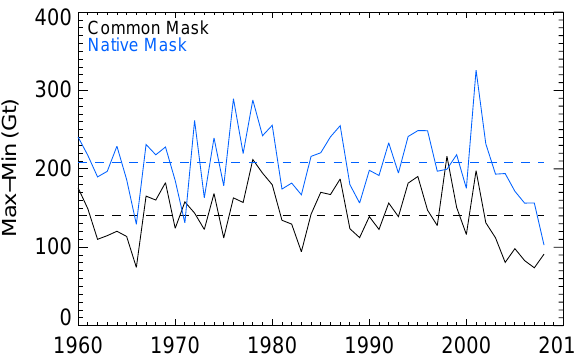
Fig. 3. Spread between highest and lowest modelled SMB annual series on the common (141Gt) and native (208Gt) masks. Dashed lines indicate 1960-2008